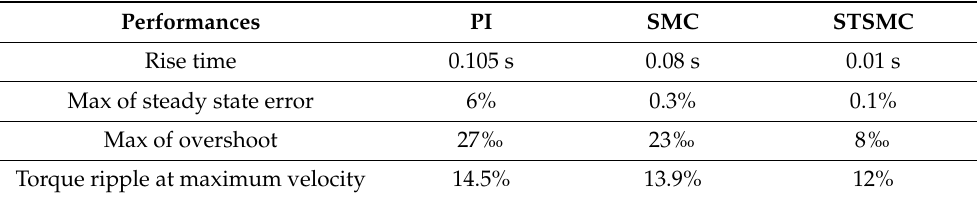
Table 1. Performances comparison of the designed controllers.